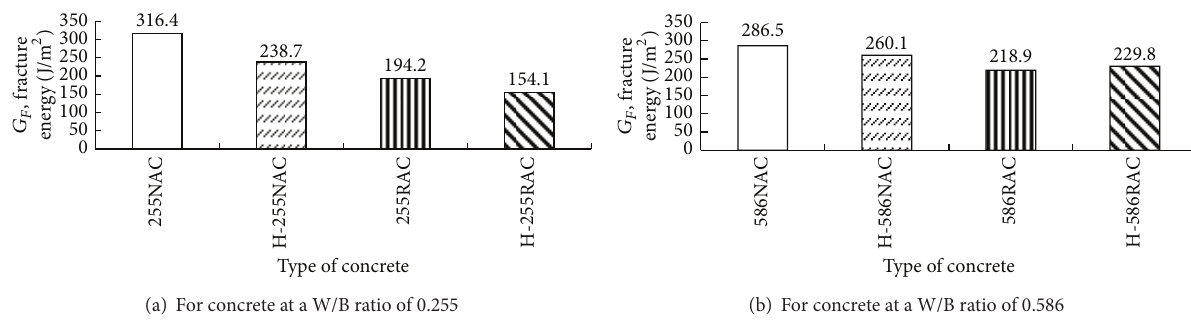
(b) For concrete at a W/B ratio of 0.586 Figure 6: Fracture energy of concrete at W/B ratios of 0.255 and